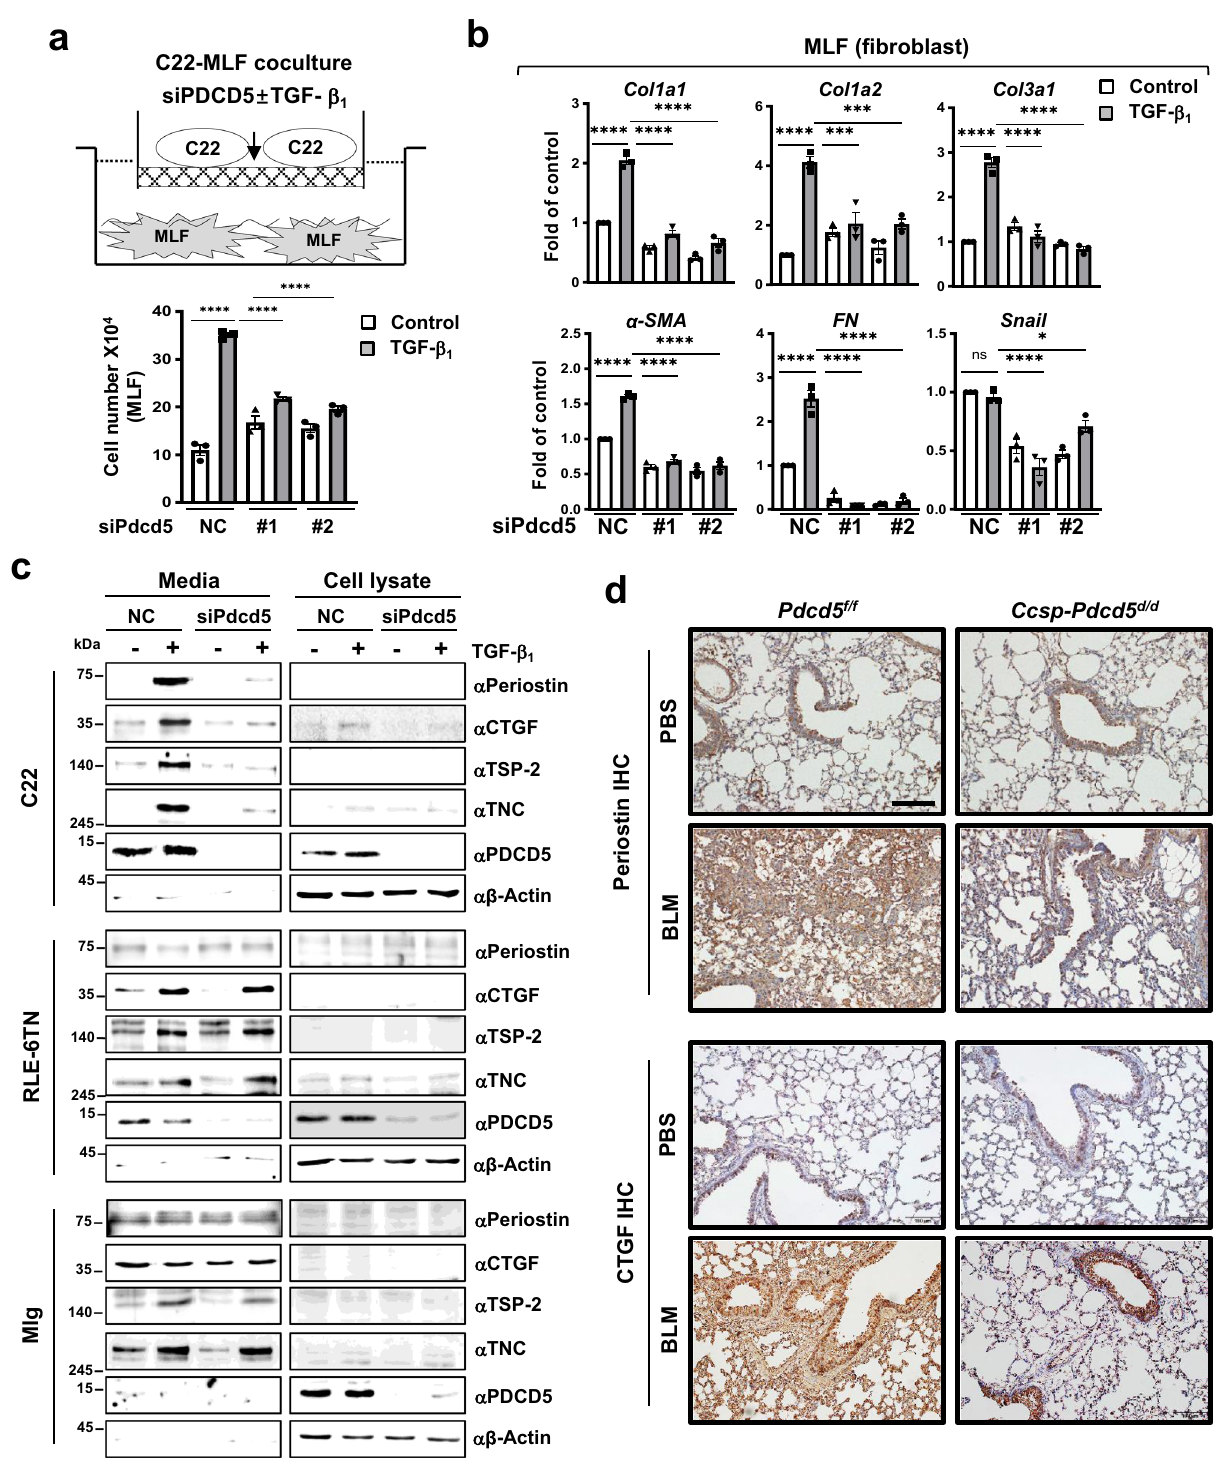
Fig. 5 PDCD5 promotes fi broblast activation via secretion of matricellular proteins. a C22 cells were plated on transwells and transfected with Pdcd5 siRNAs. Mouse primary lung fi broblast cells (MLFs) were plated in 24-well plates a day before TGF- β 1 treatment. Transwells were transferred to Mlg-containing 24-well plates. After 24 h TGF- β 1 treatment, MLFs were counted using an automated cell counter ( n = 3 in each group); **** p < 0.0001. b MLFs were cultured in C22 conditioned medium (CM). The levels of indicated genes were analyzed by qRT-PCR ( n = 3 in each group) * p = 0.0265; *** p = 0.0002; **** p < 0.0001; n.s. not signi fi cant. Error bars represent mean ± s.e.m., statistical analysis was performed with one-way ANOVA followed by Tukey ’ s test ( a, b ). c C22, RLE-6TN, and Mlg cells were treated with TGF- β 1 for 24 h. Enriched media and cell lysates were used for immunoblotting with indicated antibodies. Representative blots from three independent experiments are shown. d IHC with indicated antibodies was performed in the lung tissue from Pdcd5 f/f and Ccsp-Pdcd5 d/d mice. Scale bars = 100 μ m. Representative images from three mice in each group are shown. Source data are provided in the Source Data fi